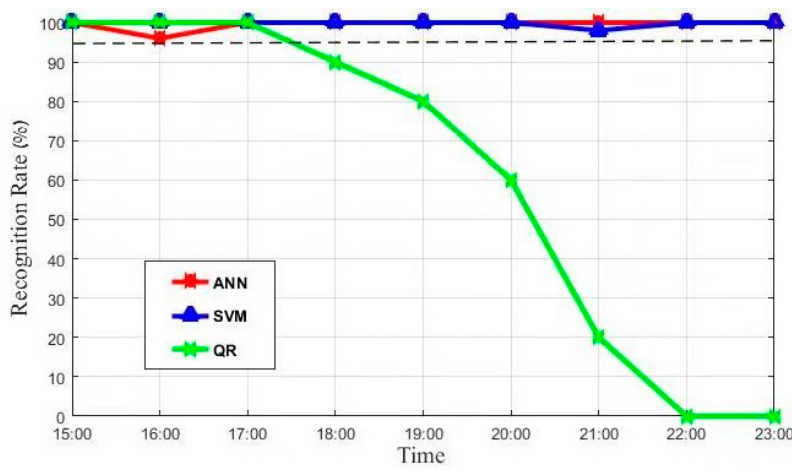
Figure 19. Contrast experiment with QR code in dark condition.